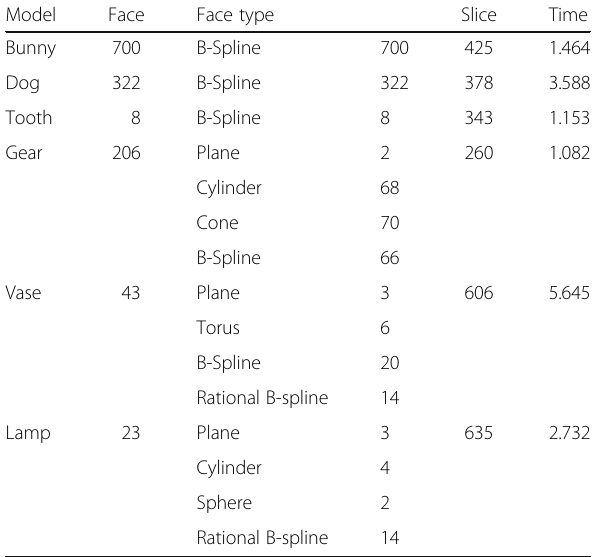
Table 1 Time cost of different B-rep models